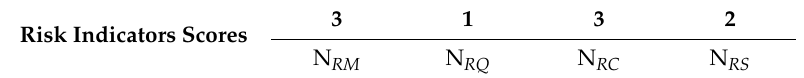
Table 11. Scores of the four risk indicators for the product “Tractor Truck 18.5